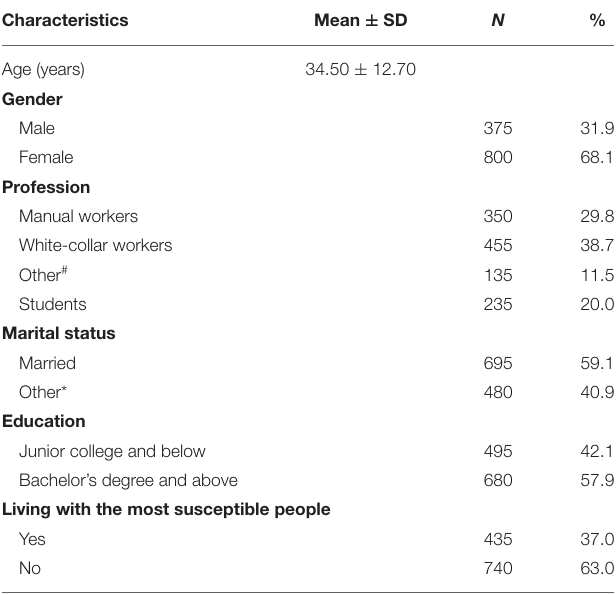
TABLE 1 | Demographic characteristics of the population surveyed regarding their COVID-19 knowledge, attitudes, and practices ( n = 1,175).